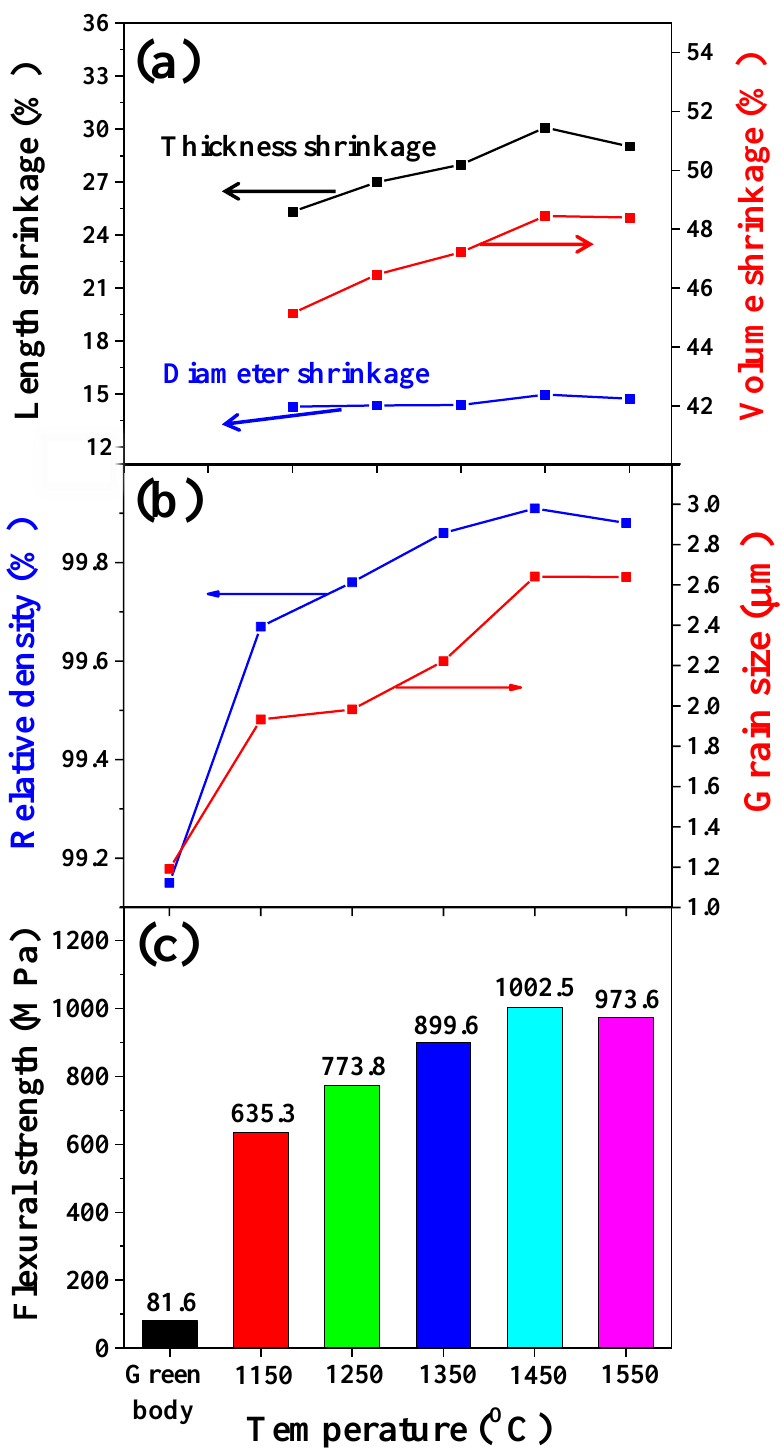
Figure 5. Characteristics of 3YSZ 3D-printed sintered body according to sintering temperature: ( a ) Length and volume shrinkage, ( b ) relative density and grain size, and ( c ) flexural strength. The XRD patterns of the 3YSZ 3D-printed sintered body were analyzed at different sintering times at 1450 °C, as shown in Figure 6. As the sintering time increased, the tetragonal XRD peaks, such as those for (002) and (200) at 34–36°, (202), (220) at 50–51°, and (113) and (311) at 59–61°, were more clearly observed, and the crystal phase of 3YSZ changed from the monoclinic phase to the tetragonal phase. Furthermore, since the peak separation at 34–36°, 50–51°, and 59–61° was more clearly observed in the sintered body with sintering times of more than 60 min, it can be inferred that a sintering time of 60 min or more is required to sufficiently develop the tetragonal phase. SEM images of the 3YSZ